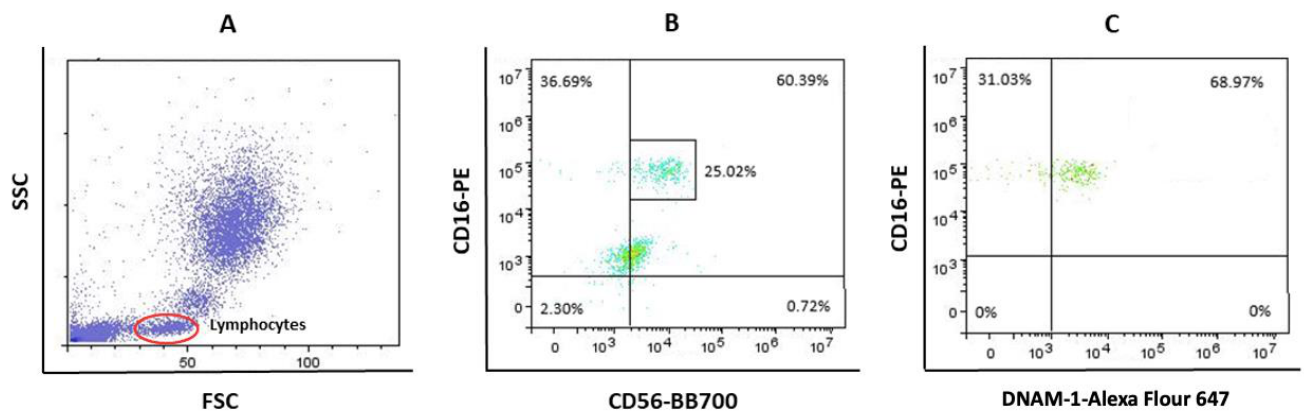
Figure 2. ( A ) Representative gates for lymphocytes (red ellipse). ( B , C ) Gating strategy for CD56dimCD16++ DNAM-1+ NK cells.